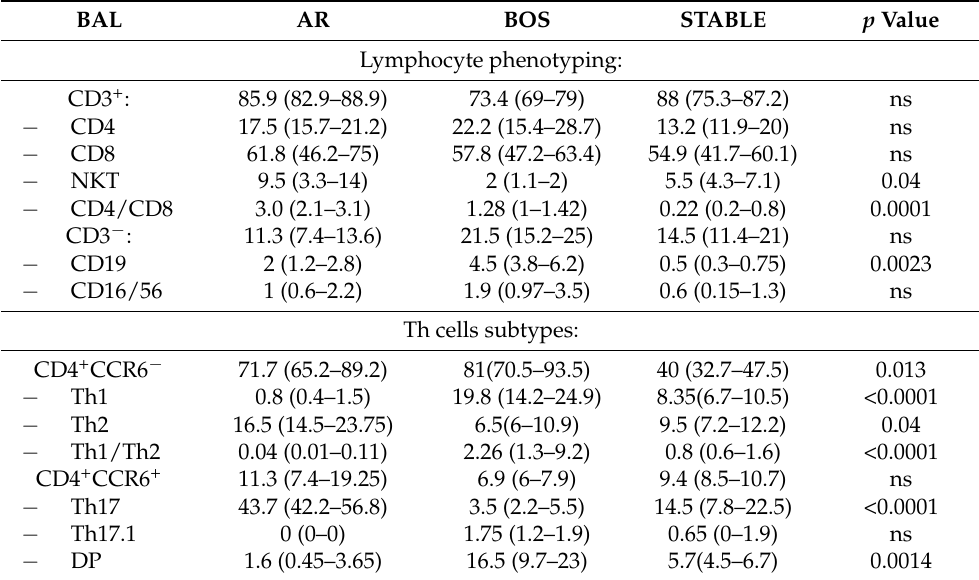
Table 3. Cellular analysis on BAL in AR, BOS and Stable